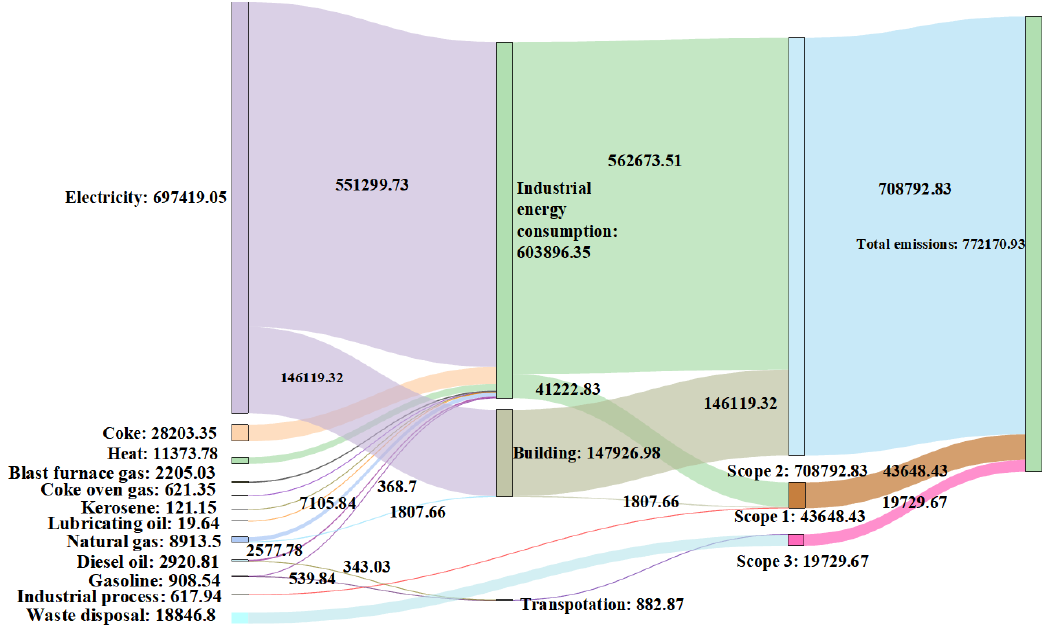
Figure 7. The Maanshan Economic and Technological Development Area (MDA) CO 2 flow chart of 2021. Measurements are indicated in tons.